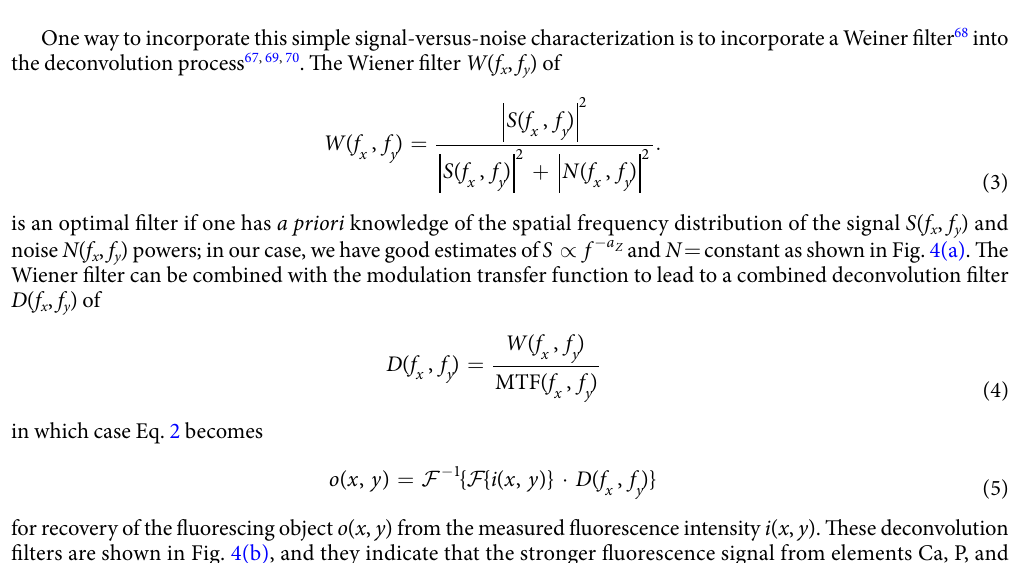
Figure 3. Resolution analysis of x-ray ptychographic images of a Chlamydomonas alga imaged in the frozen hydrated state. Two successive, independent images were obtained of the same specimen; in fact, image ( a ) is the same image as Fig. 2(b), while image ( b ) here was obtained soon after. The inset in ( c ) is a zoomed region taken from the yellow box in ( a ). The line profile indicated by a red line in the inset shows an edge response (10–90%) of 18.6 nm. Histograms of image ( a ) and ( b ) are plotted in ( d ), which shows that the images are quite consistent except at low values of optical phase (thus low electron density), which may be due to some ice evaporation. Because image ( a ) and ( b ) represent two independent images of the same object, object features should correlate while noise and other imaging flaws should not; the correlation measured as a function of spatial frequency (the Fourier ring correlation or FRC 62, 63 ) is shown in ( e ) along with the accepted 1/2-bit threshold for sufficient correlation 64 . This FRC measure gives an estimated half-period resolution of 17.8 nm for this whole, hydrated eukaryotic